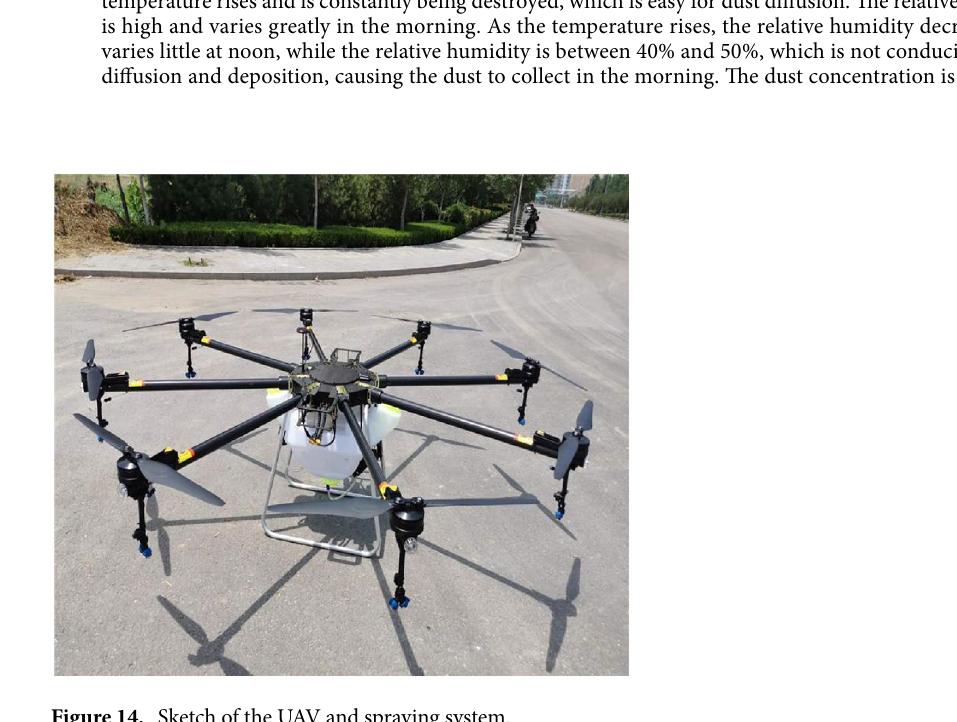
Figure 14. Sketch of the UAV and spraying